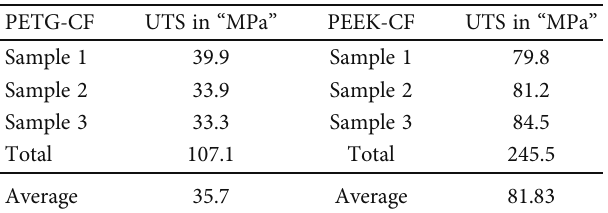
Table 3: Tensile test results for carbon-reinforced PETG AND PEEK.